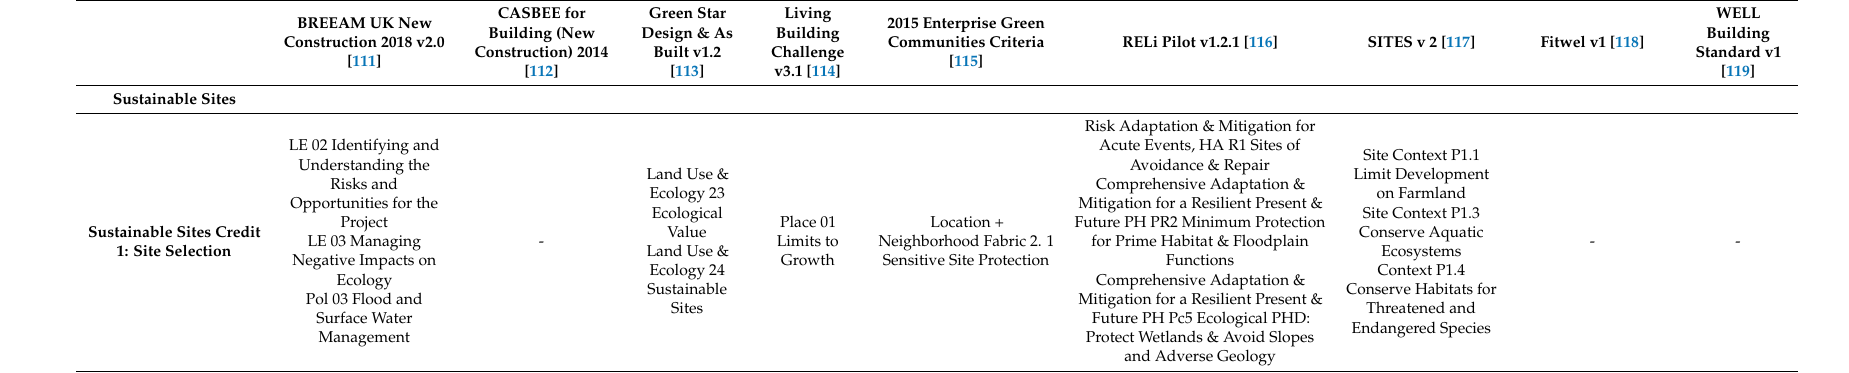
Table A3. Crosswalk of LEED Credits in Systematic Review and Other Green Building Best Practice